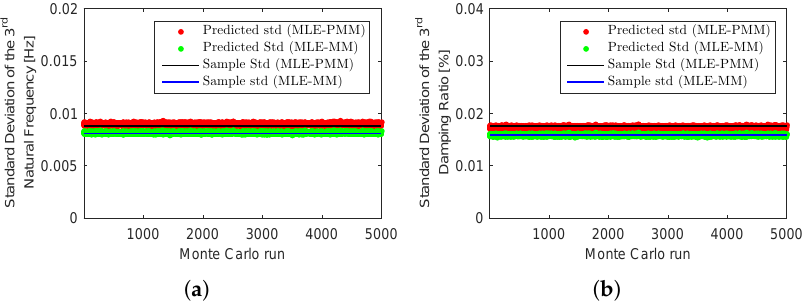
Figure 6. Monte Carlo simulation results for the five-DOF system example with 10% noise: sample standard deviation of the natural frequencies ( a ) and damping ratios ( b ) estimated for the 3rd mode both with the MLE-PMM and MLE-MM [14] and their corresponding standard deviation estimates obtained after 10